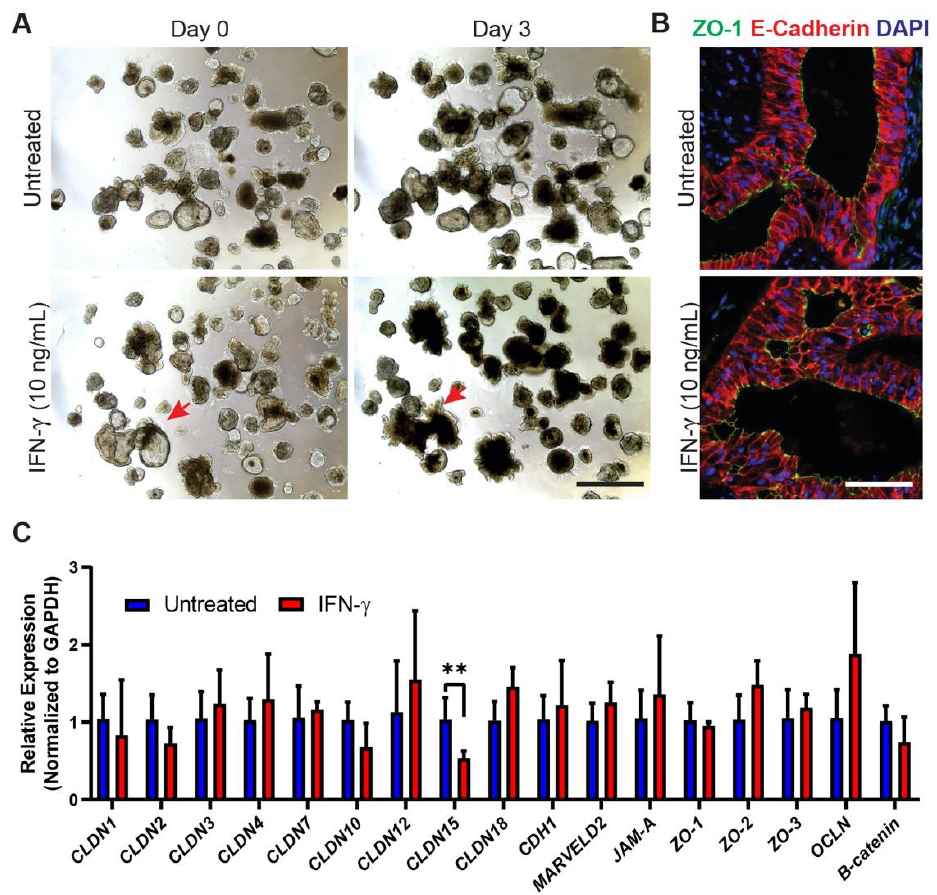
Figure 2. Acute IFN-γ exposure results in minimal disruption of junctional complexes in HIOs. ( A ) Gross morphology of HIOs after 3 days of IFN-γ treatment (10 ng/mL). IFN-γ-treated organoids displayed changes in morphology such as collapse of cystic-like organoid structures (red arrowheads). Scale Bar = 1 mm ( B ) Immunohistochemical staining of HIOs shows no disruption or mislocalization of ZO-1+ tight junctions or E-cadherin+ adherens junctions. Scale Bar = 100 m ( C ) qPCR analysis of various junctional proteins shows minimal changes in gene expression levels in HIOs treated with IFN-γ (10 ng/mL). Notably, we detected a decrease in CLDN15 expression. Data represent mean ± standard deviation with relative expression values being generated from 1–3 independent experiments ( n = 3–9 biological replicates for each gene with each biological replicate value being averaged from 2 technical replicates of qPCR data). ** p < 0.01, multiple t -tests with Benjamini–Hochberg FDR correction.